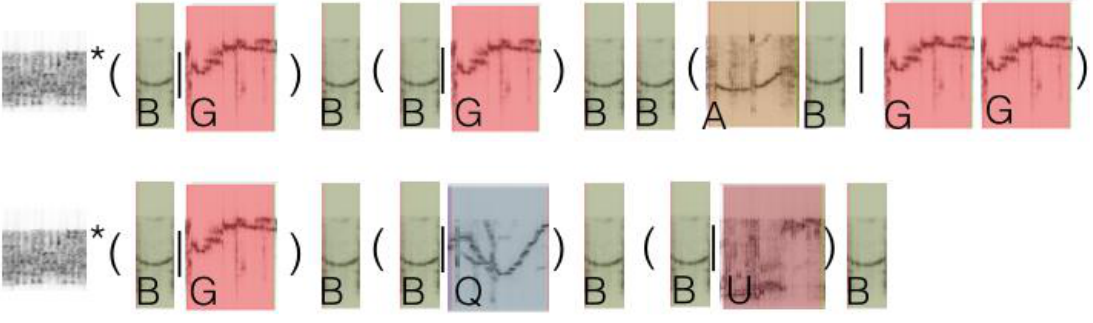
Figure 16. Two rules extracted from our data set. (x|y) represents OR and a star represents a repetition of the previous symbol as often as needed to match the